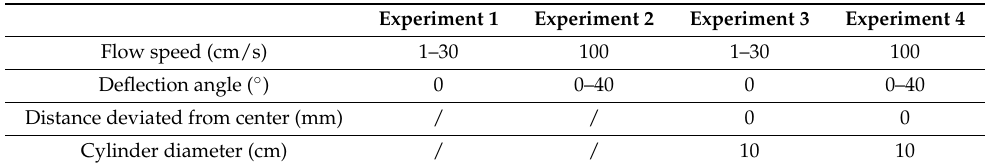
Table 2. Experiment conditions and flow